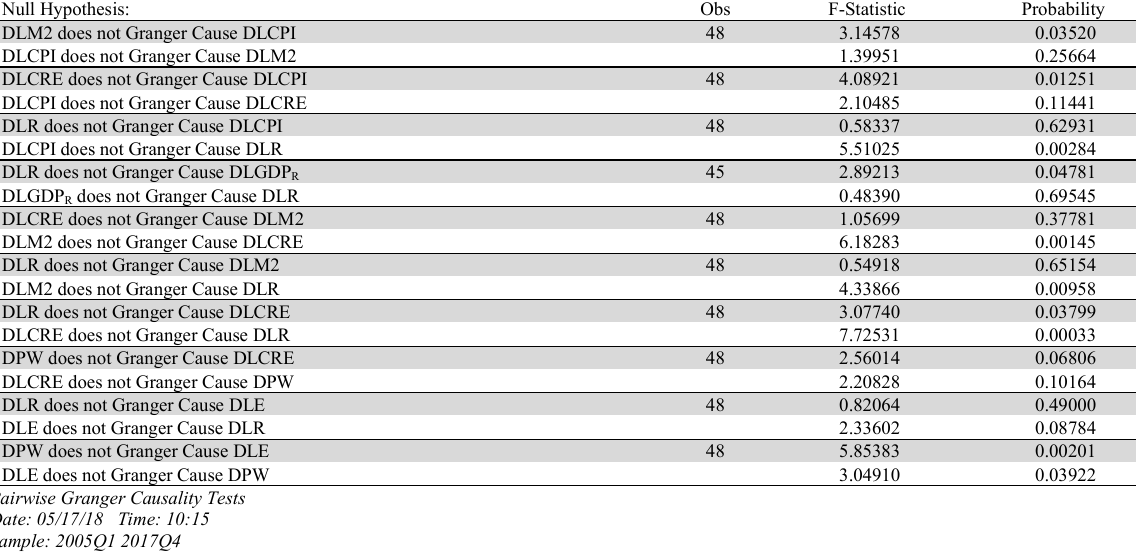
Granger causality